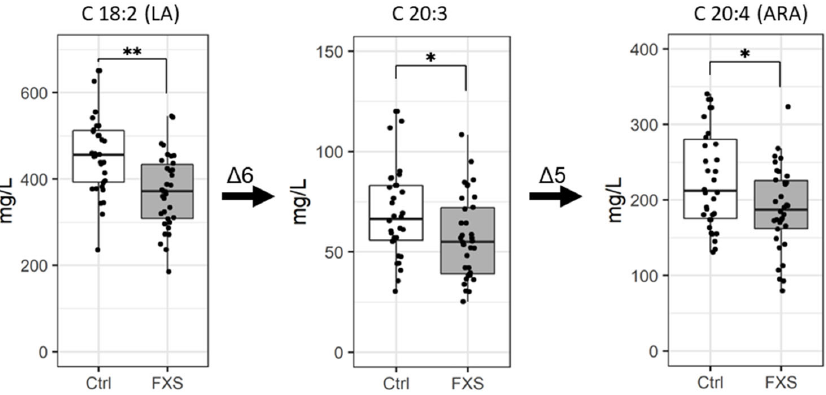
Figure 1. Concentrations of selected ω‐ 6 FAs in plasma. Levels are expressed in mg/L of plasma. * p ≤ 0.05; ** p ≤ 0.01. Δ 6, delta6 ‐ desaturase; Δ 5, delta5 ‐ desaturase.